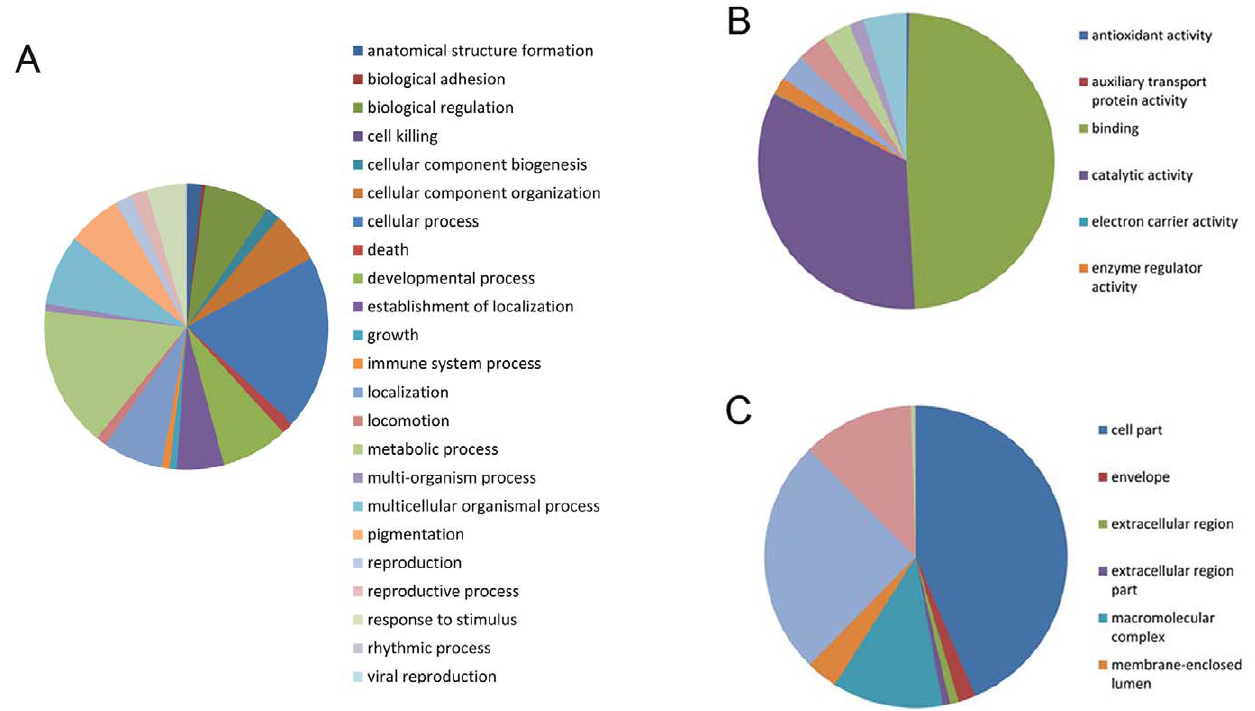
Figure 6. Distribution of the significantly up- and down-regulated transcripts in the subclasses of GO classification. (A) Biological process. (B) Molecular function. (C) Cellular component.